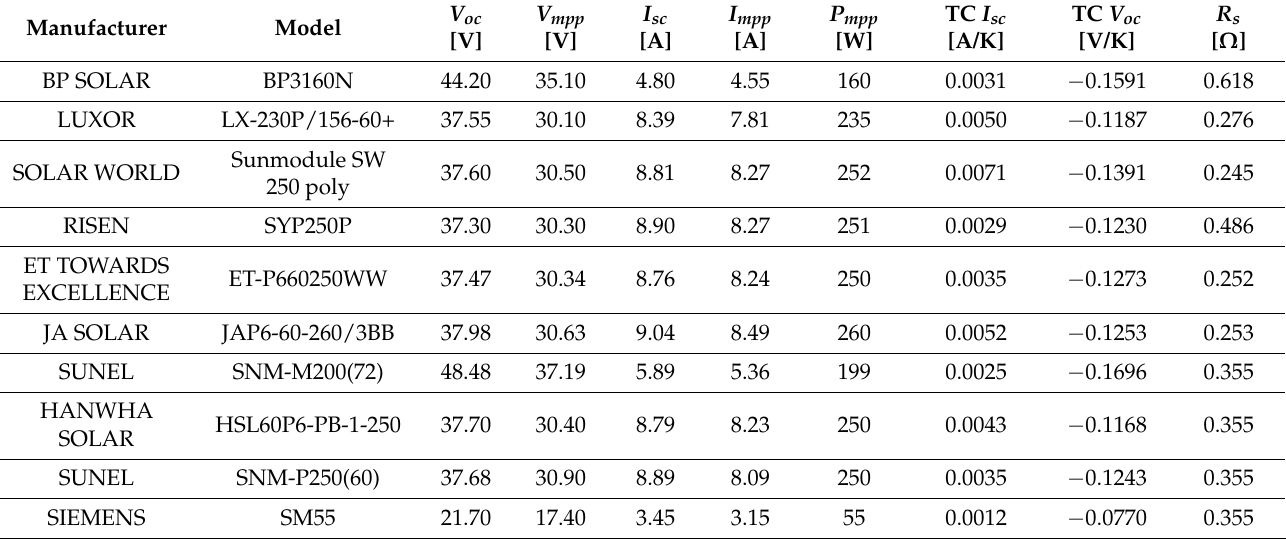
Table A1. Summary of electrical parameters of all 10 PV modules models inspected in